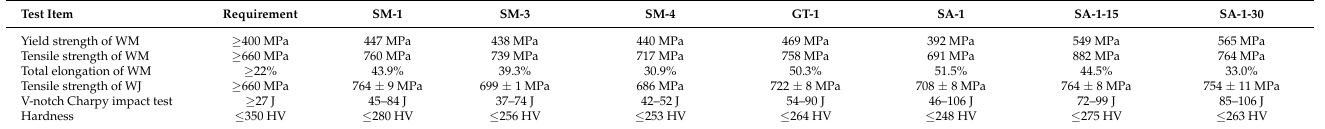
Table 10. Summary of the mechanical properties of the welded joint (WJ) and the weld metal